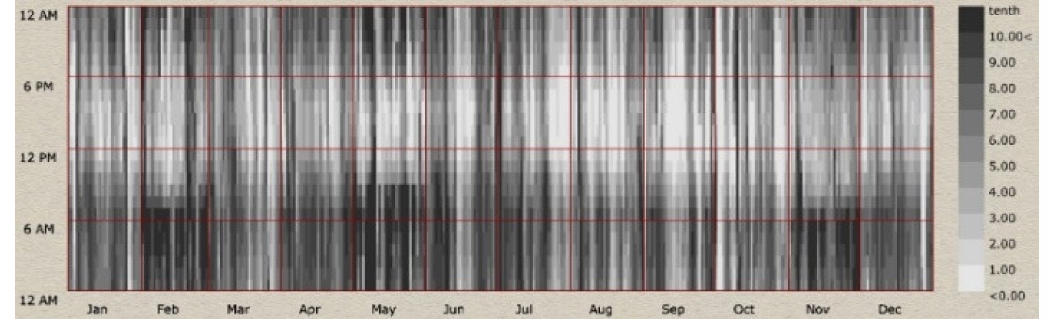
Figure 5. Yearly total cloud cover (10th) for Sydney, NSW. Analyzed and illustrated by the Ladybug tool based on a weather data file containing weather data that are used for running energy-usage simulations in the standard EnergyPlus